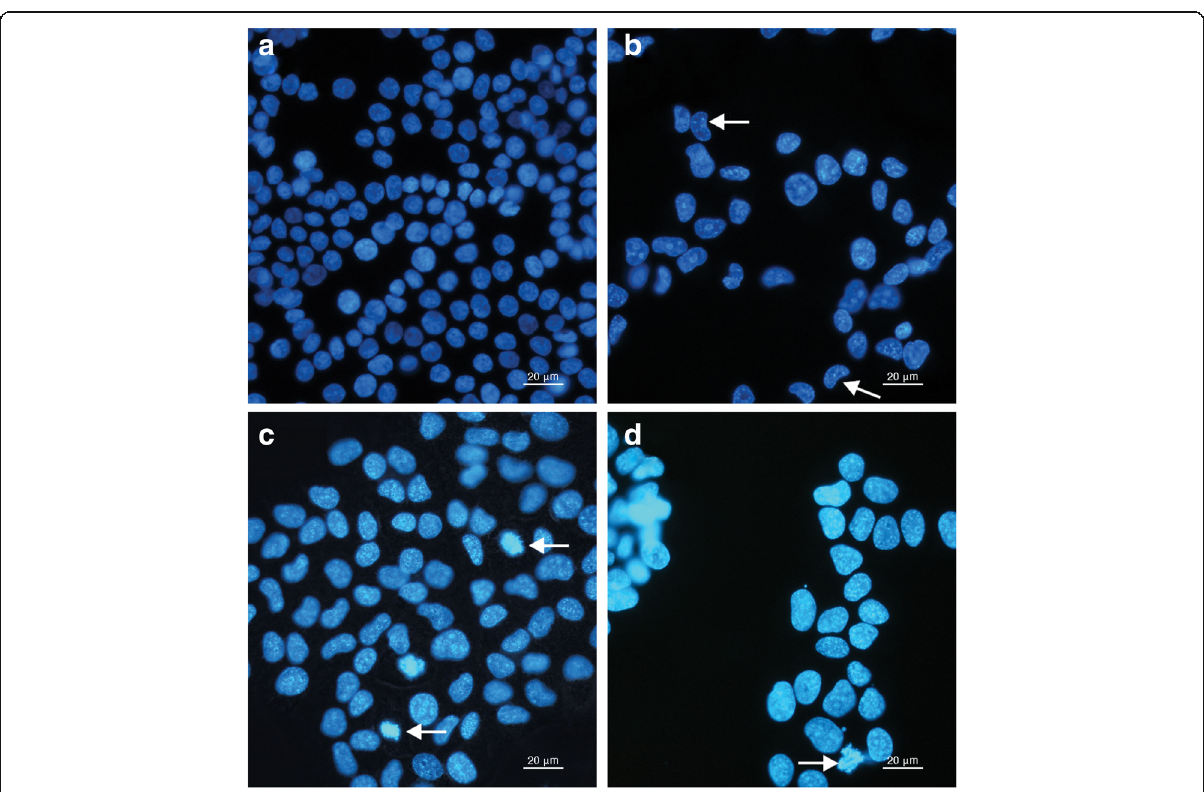
Fig. 4 Control HT 29 cells ( a ), cells treated with 500 μ g/mL SPK-H (48 h) ( b ), 500 μ g/mL SAK-H (48 h) ( c ) and 500 μ g/mL SPK-L (72 h) ( d ) and stained with Hoechst (magnification 40x). All pictures are typical of three independent experiments each performed under identical